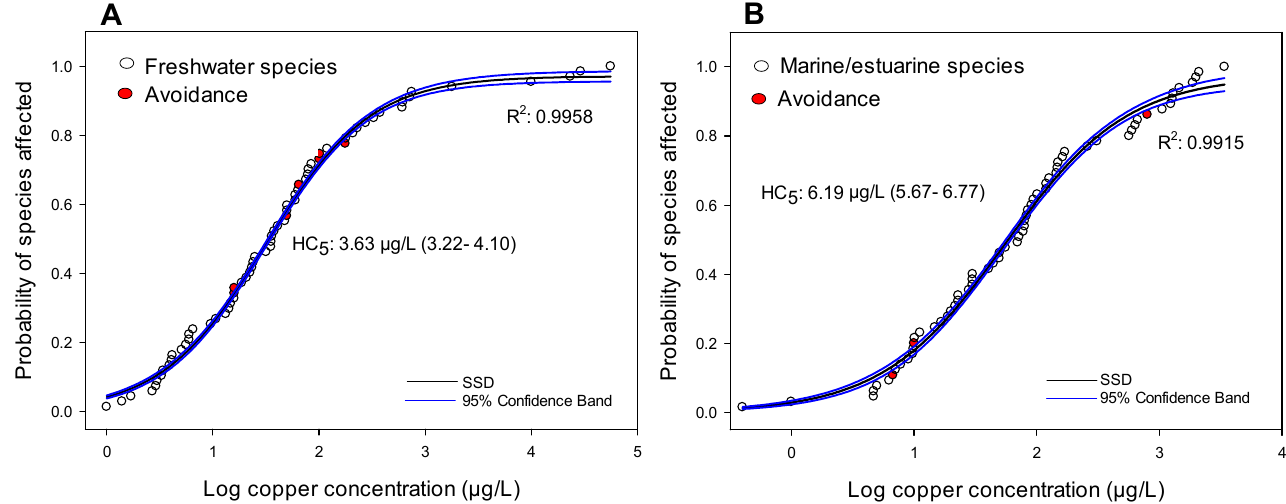
Figure 4. Species sensitive distribution (SSD), and 95% confidence intervals, expressed as the probability of the species being affected according to the log of the copper concentrations, considering the freshwater ( A ) and estuarine/marine ( B ) species. The spatial avoidance response is represented by red circles. Values of hazard concentrations for 5% of the species (HC 5 ) and the confidence intervals are also shown for each group of data.